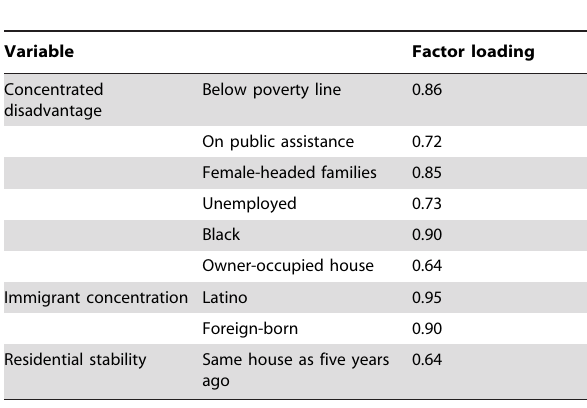
Table 1. Oblique rotated factor pattern loadings ( $ 0.60) in 825 Florida zip